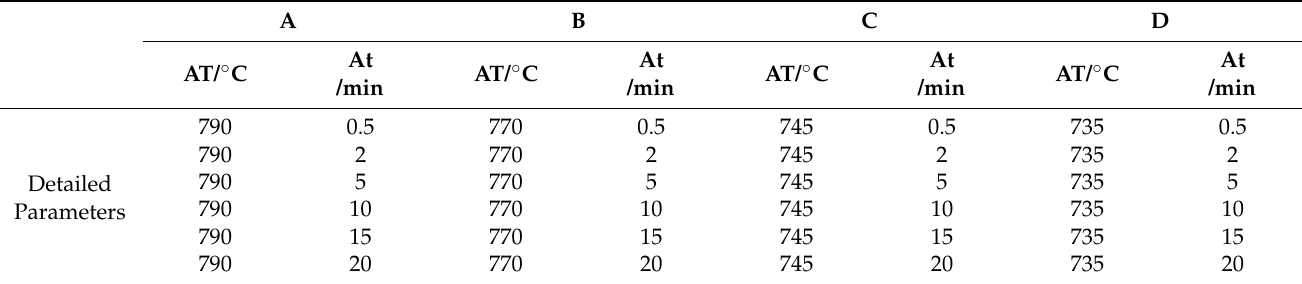
Table 2. Detailed heat-process parameters at different annealing temperatures (ATs) and annealing times